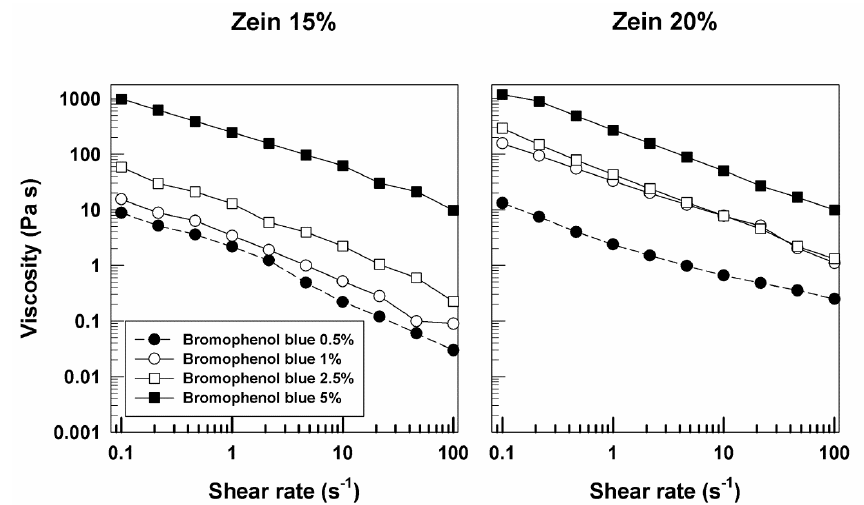
Figure 7. Evaluation of the viscosity of zein samples containing bromophenol blue as a function of the shear rate.